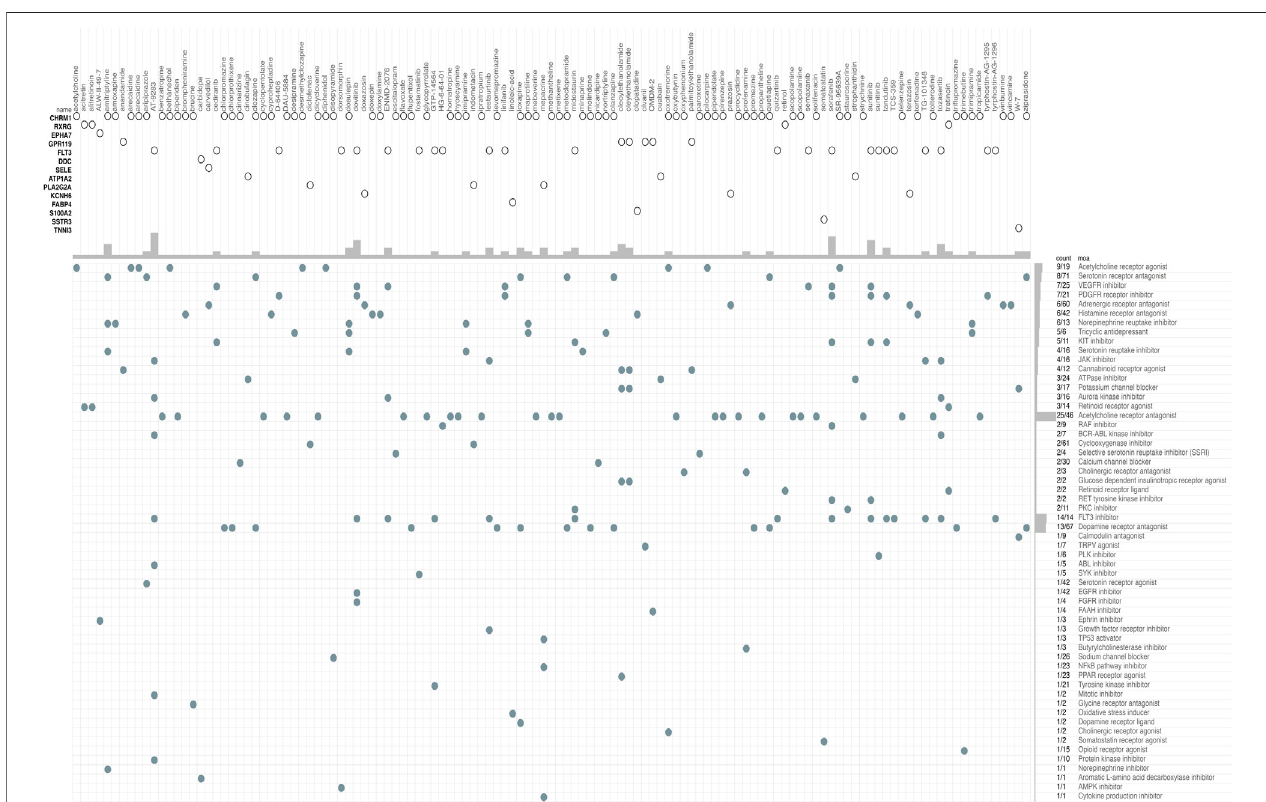
FIGURE 8 | CMap database analysis identi fi es novel candidate drugs targeting the DEGs between high-risk and low-risk patients in the TCGA cohort. CMap, connectivity map.